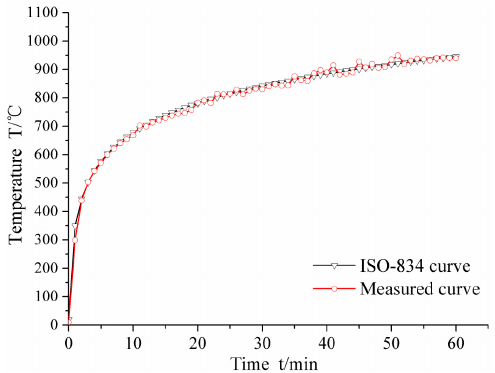
Figure 16. The furnace temperature curve.